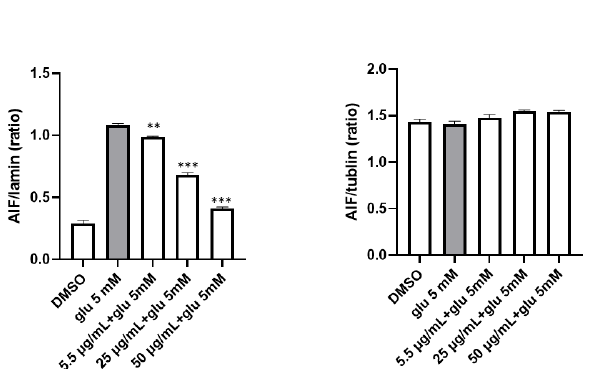
Figure 4. The 75% EEPF suppressed glutamate-induced AIF translocation to the nucleus. ( a ) Im-